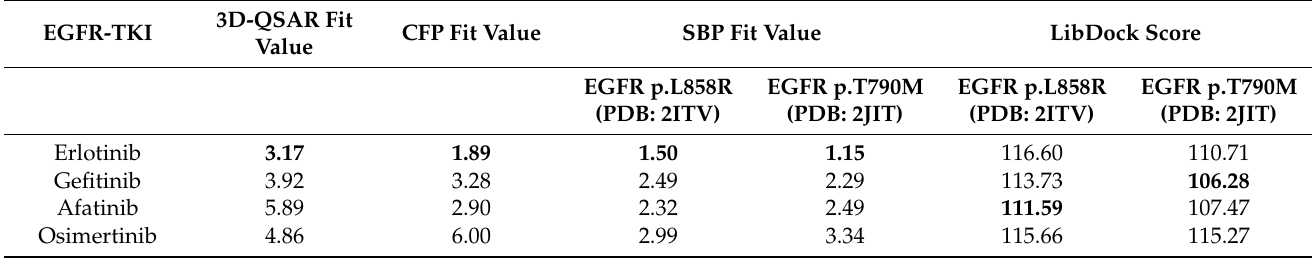
Table A1. Thepharmacophore-derivedfitvaluesanddockingscoresofclinicallyapprovedEGFRinhibitors. EGFR-TKI